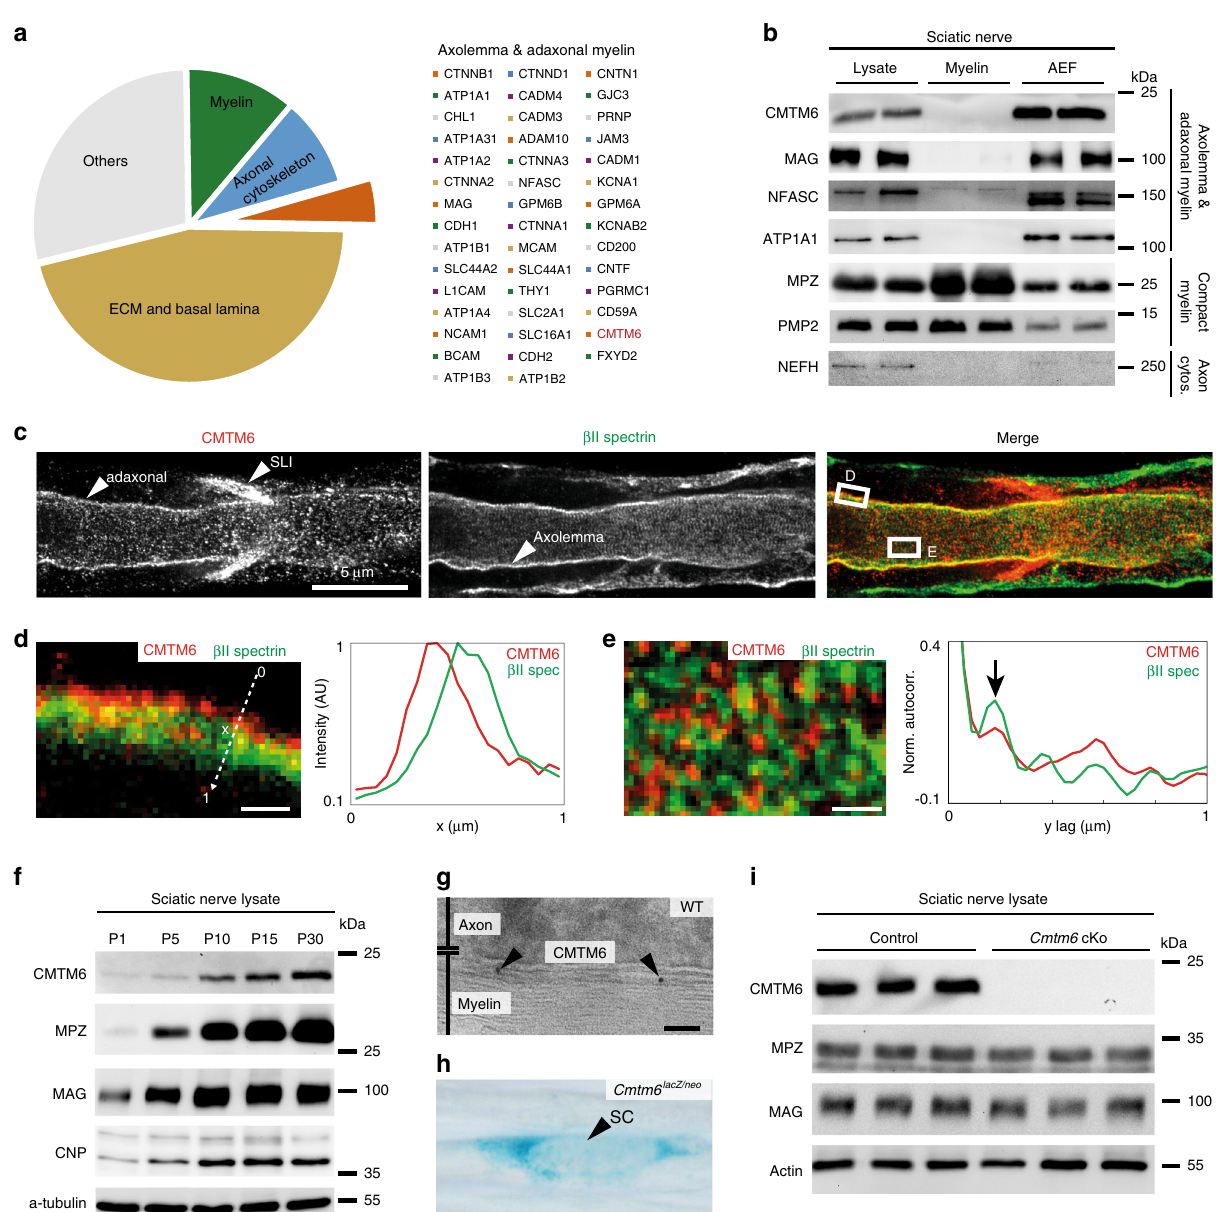
Fig. 1 Identi fi cation of CMTM6 as adaxonal Schwann cell protein. a Quantitative proteome analysis of axogliasome-enriched fraction (AEF) from mouse sciatic nerves discovers CMTM6 (see Supplementary Fig. 1, 2 and Supplementary Data 1). b Immunoblot-analysis identi fi es enrichment of CMTM6 in the AEF compared to nerve lysate and myelin similar to markers for axolemma/adaxonal myelin (ATP1A1/NFASC/MAG). c STED-micrographs of teased fi bers immunolabeled for CMTM6 (red) and betaII-spectrin (green). White arrowheads point at adaxonal myelin, Schmidt – Lanterman-incisure (SLI) and axolemma. Boxes indicate areas enlarged for line pro fi le of intensities ( d ) and autocorrelation analysis ( e ). Scale bar, 5 µ m. Age of mice 4 – 5 months. Cross section Supplementary Fig. 3a. d Line pro fi le shows CMTM6-immunolabeling (red) adjacent to axolemma identi fi ed by betaII-spectrin-immunolabeling (green). Scale bar, 500 nm. e Autocorrelation analysis reveals a peak of periodicity of CMTM6 immunolabeling (red) longitudinally along the axon/myelin unit similar to betaII-spectrin-immunolabeling (green), indicated by black arrow. Scale bar, 500 nm. f Immunoblot-analysis shows developmentally increasing abundance of CMTM6 in sciatic nerves similar to myelin markers (MPZ, MAG, CNP). g Immunogold labeling of cross-sectioned sciatic nerve shows CMTM6-labeling (black particles; indicated by black arrowheads) con fi ned to adaxonal myelin. Scale bar, 100 nm. h X-Gal-histochemistry on teased fi bers shows activity of the Cmtm6 lacZ/neo -allele (Supplementary Fig. 4a) in Schwann cells (indicated by black arrowhead). Scale bar, 25 µ m. i Immunoblot- analysis reveals CMTM6-de fi ciency in sciatic nerves of Cmtm6 -cKo mice (Supplementary Fig. 4). Blot shows n = 3 mice per genotype. Teased fi ber labeling Supplementary Fig. increased axonal diameters are a plausible explanation for electron microscopy (Supplementary Fig. 8a, b) and immuno- increased NCV and altered behavioral performance of Cmtm6- blotting (Supplementary Fig. 8c – f), Cmtm6 -cKo-mice displayed cKo-mice. unaltered neuro fi lament density and phosphorylation, implying Radial axonal growth is frequently associated with altered that the increase of axonal diameters re fl ects genuine radial density and phosphorylation of neuro fi laments 27 . However, by growth.